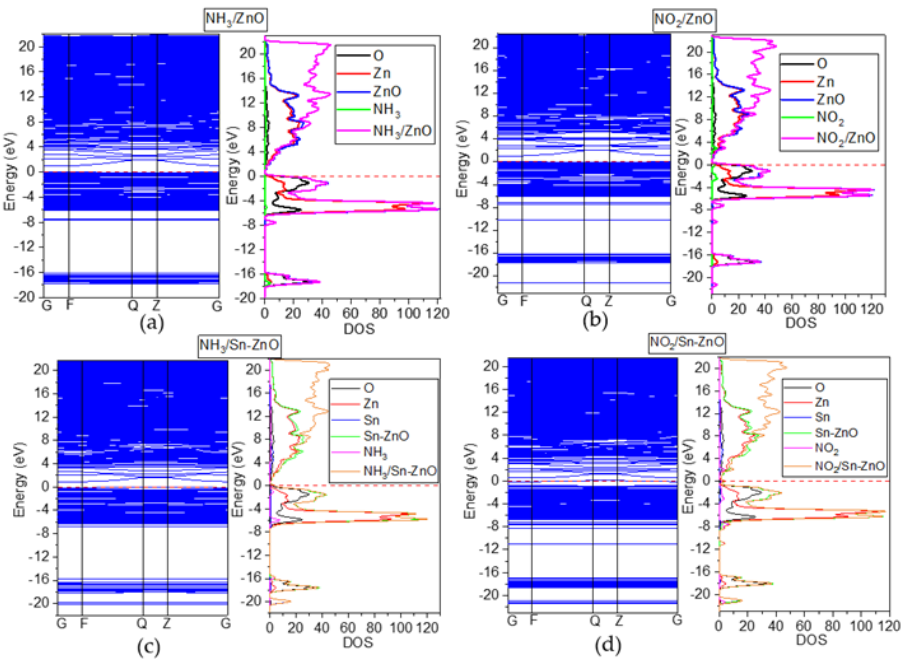
Figure 4. Band structures and DOS plots for physisorbed ( a ) NH 3 /ZnO (101), ( b ) NH 3 /Sn − doped ZnO (101), ( c ) NO 2 /ZnO (101), and ( d ) NO 2 /Sn − doped ZnO (101) surfaces. The band structures and DOS of NO 2 and NH 3 adsorbed on either the ZnO (101) or NH 3 /ZnO (101), NO 2 /ZnO (101), NH 3 /Sn-doped ZnO (101), and NO 2 /Sn-ZnO (101), the